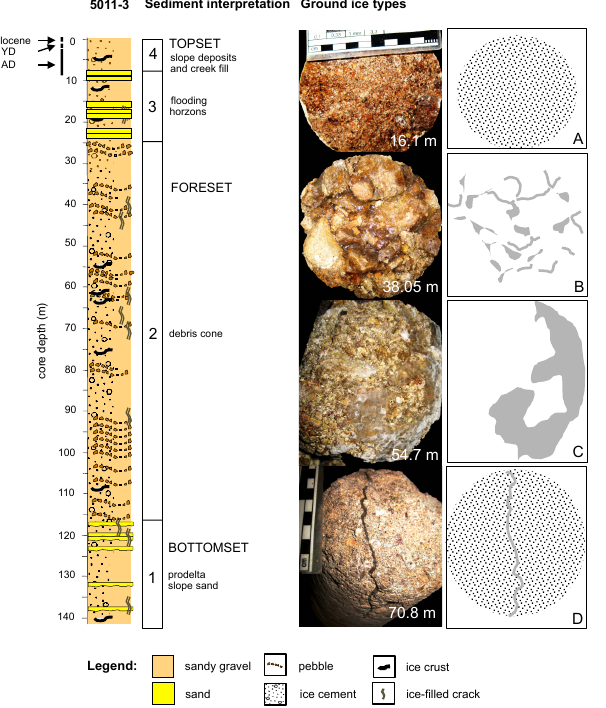
Figure 2. Left: the lithological log of core 5011-3 including pollen- based stratigraphy from Andreev et al. (2012) and sediment inter- pretation from Schwamborn et al. (2012a); YD = Younger Dryas, AD = Allerød. Right: photographic examples and generalised cry- otexture of ground ice in the core. The scale is in cm, the core diam- eter is 11cm. (A) ice cement in a sandy matrix, (B) pore space fill- ings in a pebble layer, (C) ice crust around sandy gravel, (D) near- vertical ice vein in sandy